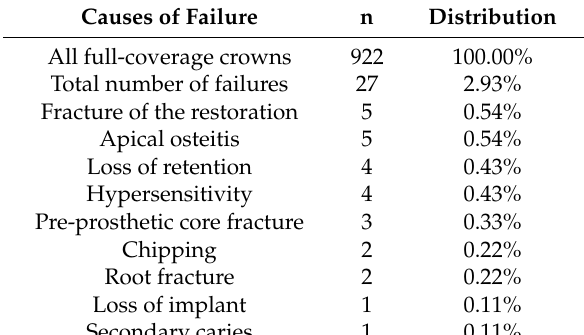
Table 5. Reasons for biological or technical failure of crown restorations.